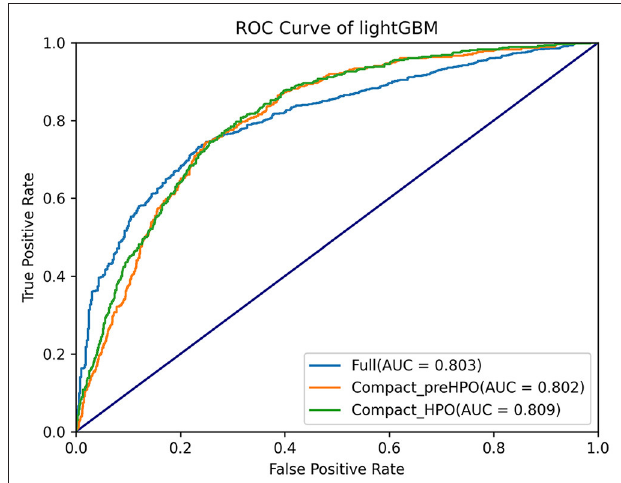
FIGURE 5 | Comparisons of full parameters, pre-HPO and after-HPO compacted parameters